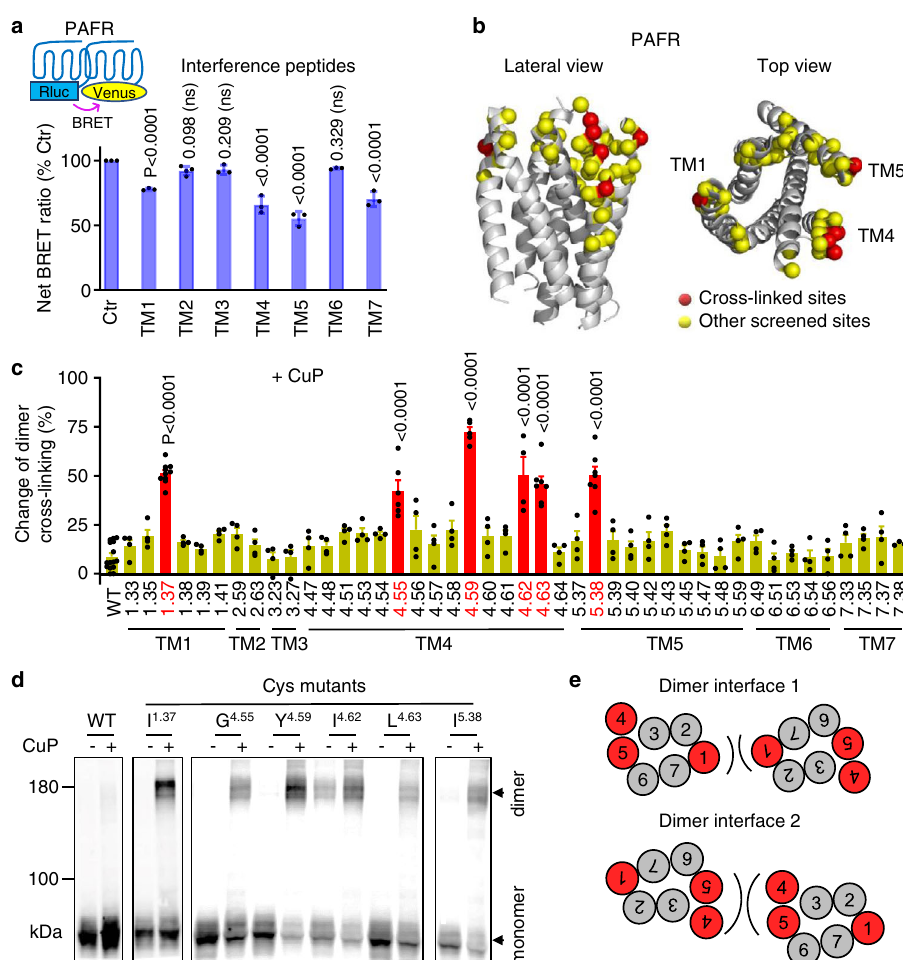
Fig. 2 | Cysteine cross-linking identi fi es TM1, TM4, and TM5 at the PAFR dimer interface. a Effects of interference peptides derived from the indicated trans- membrane domains on the BRET signal between PAFR molecules. BRET signal was measured from cells co-transfected with PAFR-Venus and PAFR-Rluc after incu- bating with 10 μ M of the indicated peptide for 2h. Data are mean±SEM from n =3 – 4 biologically independent experiments performed in triplicates and were analyzed using one-way ANOVA with Dunnett ’ s multiple comparisons test, com- paredwithcontrol(Ctr,pureDMSO). b 3Dstructureofthe7TMofPAFR(PDBcode: 5ZKQ)withallCyssubstitutionshighlightedeitherbyayellowsphere( α carbon)or byaredsphereforthosewellcross-linkedinTM1,TM4,andTM5. c ChangeofPAFR dimer rate induced by CuP treatment for the WT and the indicated mutants.